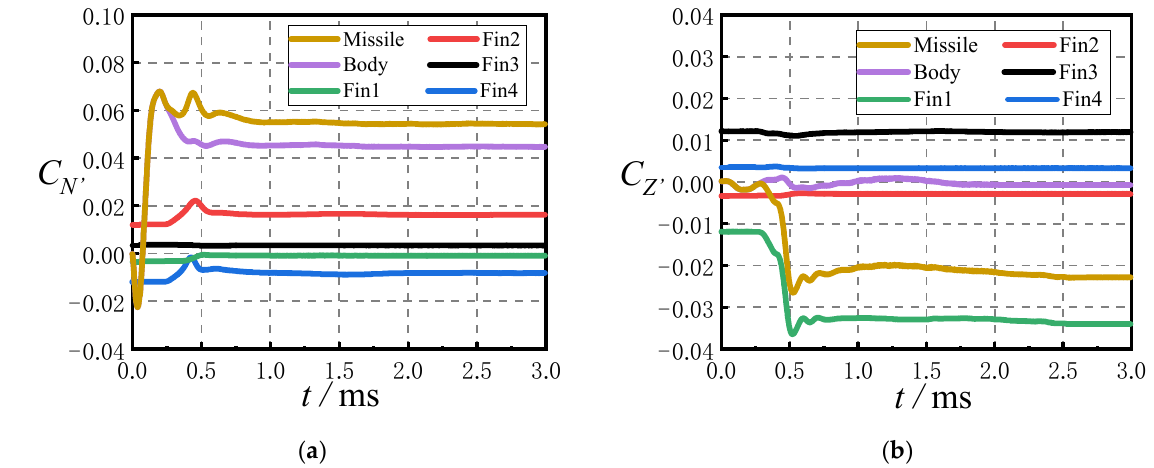
Figure 15. Variation of aerodynamic coefficients of different aerodynamic components with time since lateral jet startup: ( a ) Normal force coefficient; ( b ) lateral force coefficient.